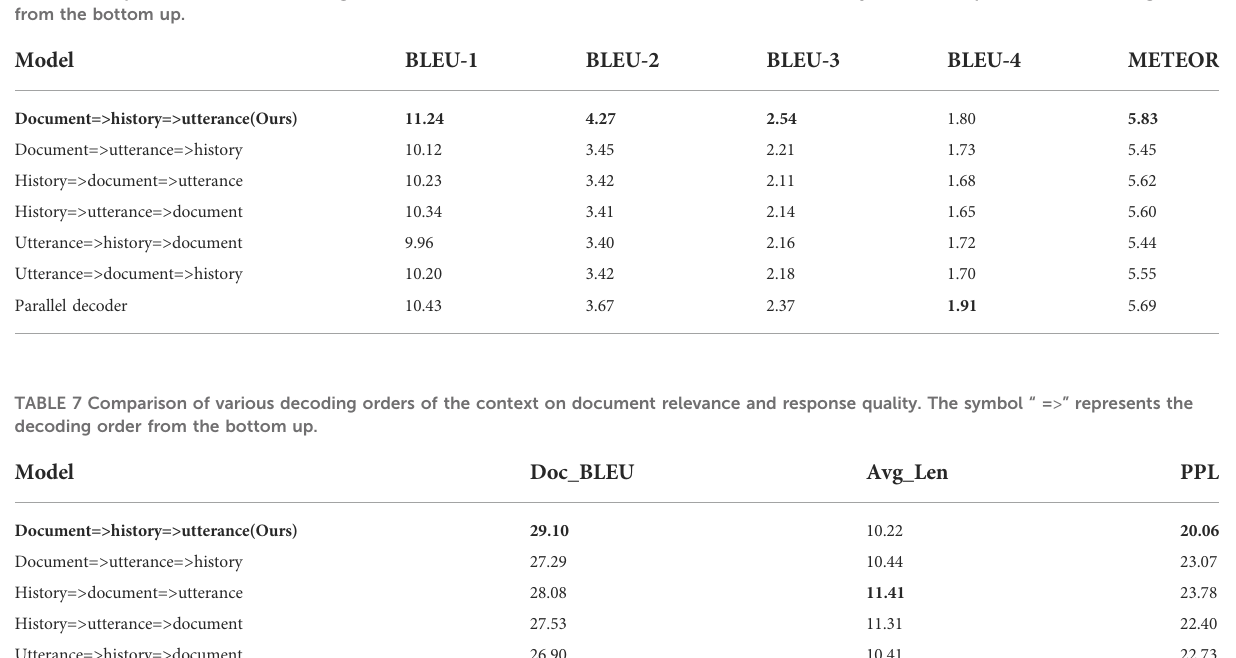
Parallel decoder